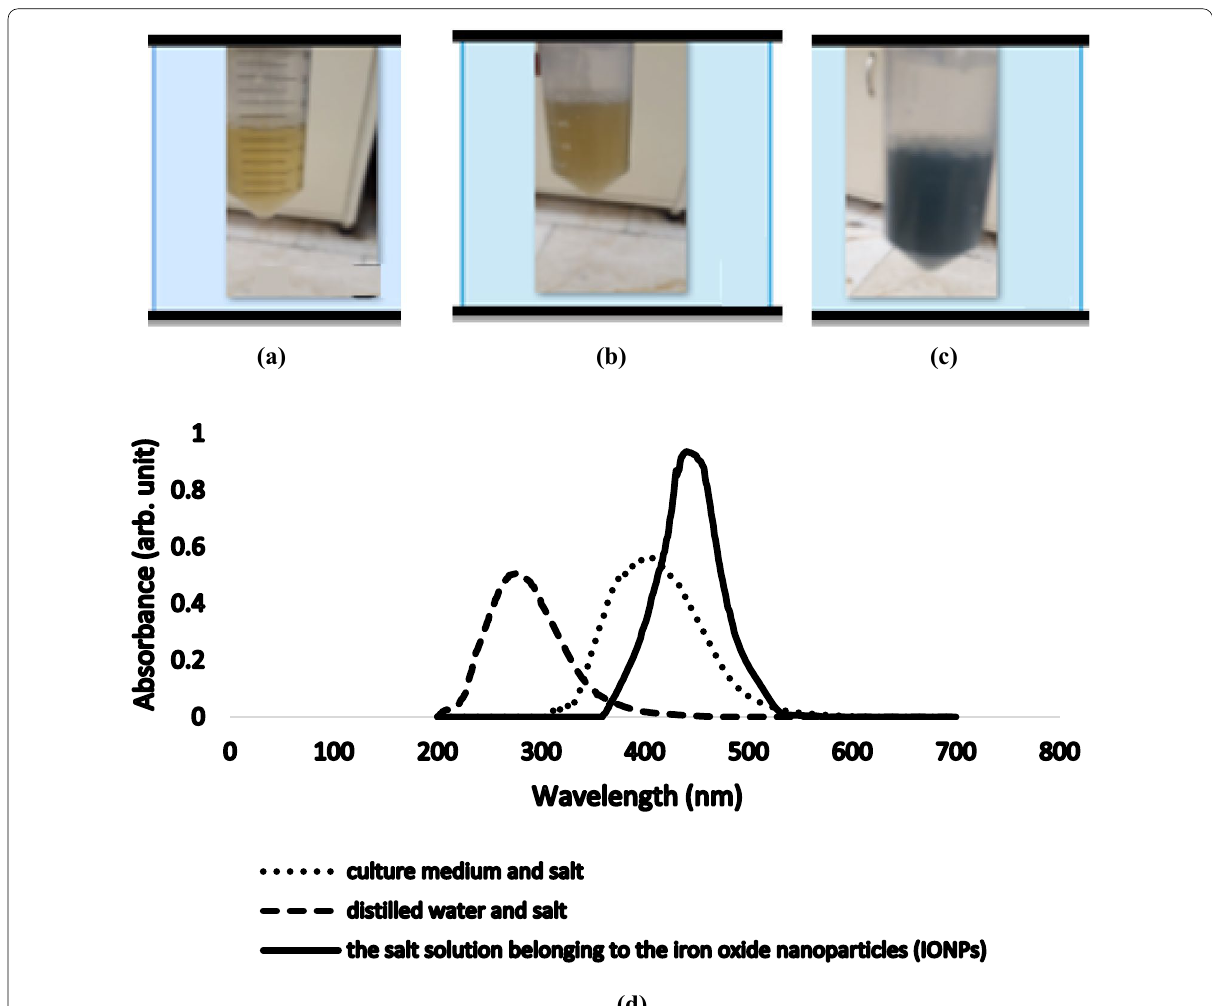
Fig. 1 a Bacterial suspension, b bacterial suspension and the salt solution at the onset, c the bacterial suspension and the salt solution after 20 min, d UV–visible spectrophotometry